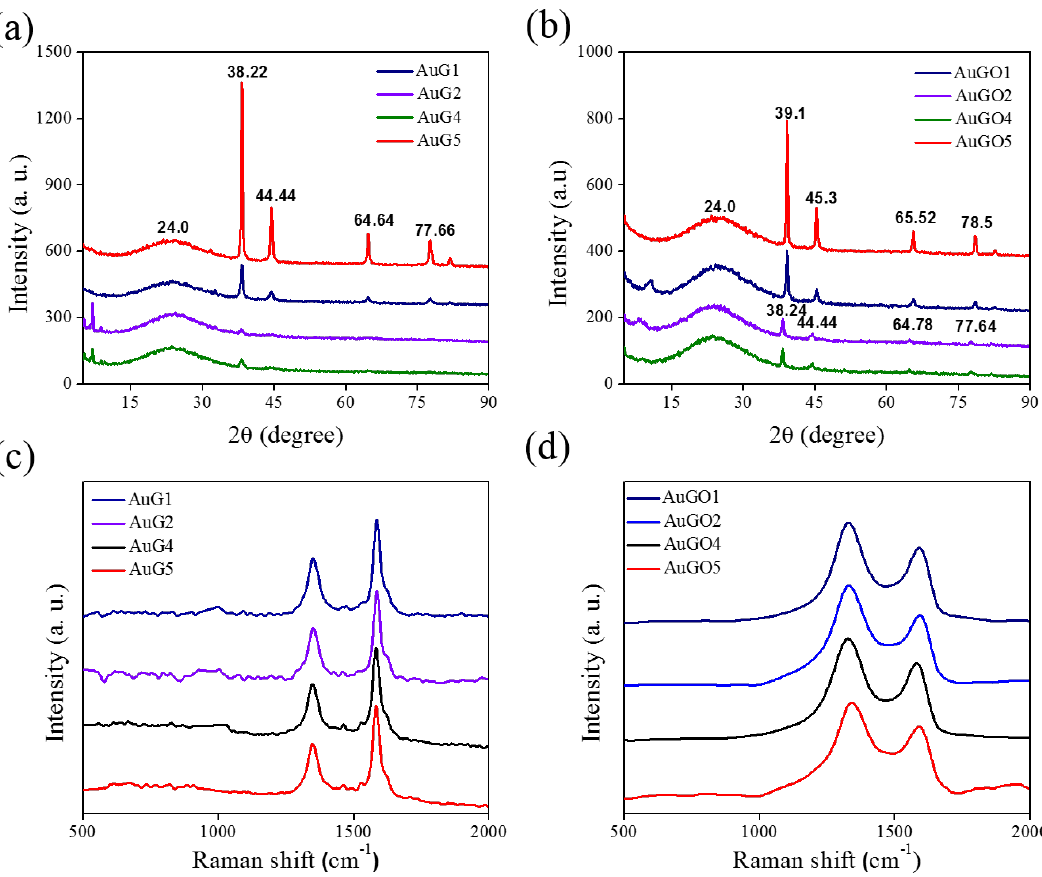
Figure 3. XRD spectra of ( a ) Gr / Au and ( b ) GO / Au NCPs, and Raman spectra of ( c ) Gr / Au and ( d ) GO / Au NCPs.